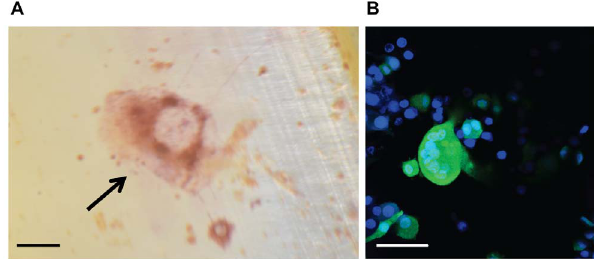
Figure 4. CID induced osteoclasts formed on native mineral- ized substrates. (A) TRAP-positive osteoclasts on human dentin slices. Dentin slices created from human teeth were seeded with RAW264.7 +- iRANK cells and cultured in the presence of AP20187 for 9 days. The slides were fixed and stained for TRAP and multinucleated TRAP- positive cells were shown in purple (arrow) (scale bar=100 m m). (B) Confocal micrograph of multinucleated osteoclasts on mouse calvarial disc. Calvarial discs were seeded with RAW264.7 + iRANK cells and osteoclast formation was induced by the addition of AP20187. Cells were imaged by confocal microscope; blue fluorescence indicates nuclei by Hoechst stain, while green fluorescence indicates GFP expression in RAW264.7 + iRANK cells (scale bar=50 m m).